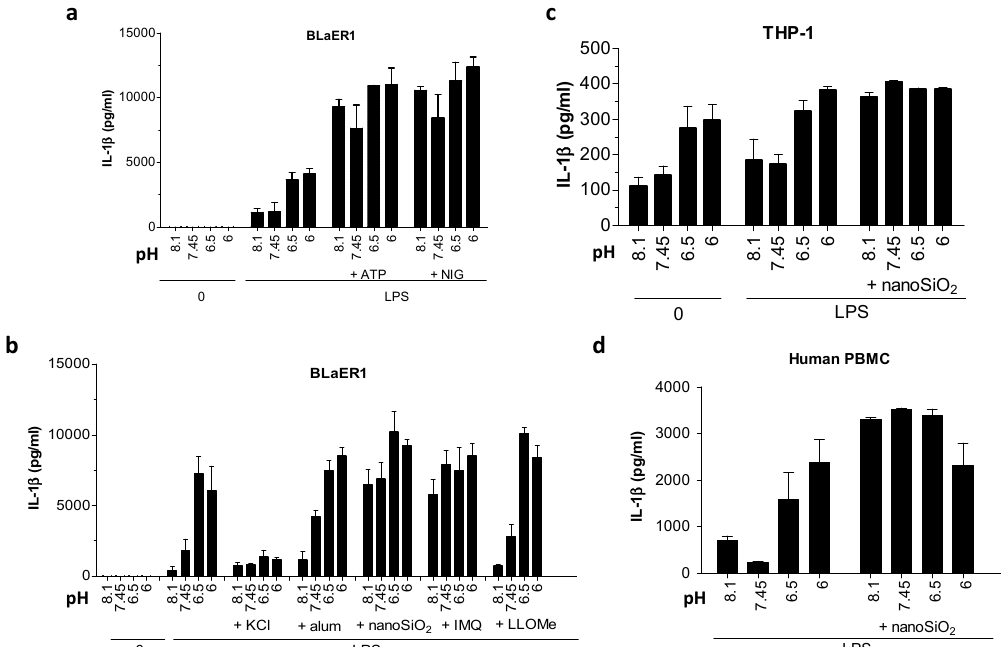
Figure 1. The effect of extracellular pH on interleukin 1 beta (IL-1 β ) release from human monocytes and macrophages. ( a ) IL-1 β levels in supernatants after the differentiated BLaER1 monocytes were primed with 100 ng/mL lipopolysaccharide (LPS) for 6 h and then treated for 1 h with stimulation buffers of various pH values alone or containing 5 mM ATP or 10 μ M nigericin. ( b ) IL-1 β levels after BLaER1 were primed as in ( a ) and treated for 3 h with buffers with various pH values alone or containing 134 mM KCl, 400 μ g/mL aluminum salts, 180 μ g/mL nanoparticles of silica (nanoSiO 2 ), 20 μ M imiquimod or 1 mM L-leucyl-L-leucine methyl ester (LLoMe). ( c , d ) IL-1 β levels by ELISA assay in supernatants after THP-1, differentiated with 100 ng/mL phorbol 12-myristate 13-acetate (PMA) or peripheral blood mononuclear cells (PBMCs) were primed with 100 ng/mL LPS for 6 h and exposed for 3 h to buffers with various pH values alone or containing 180 μ g/mL nanoSiO 2 .